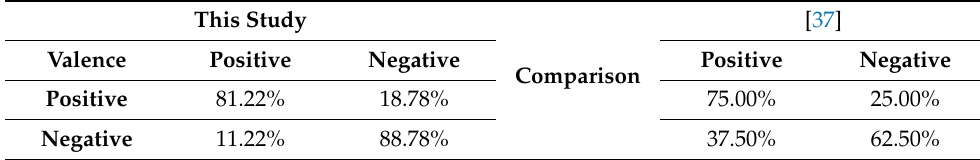
Table 12. Valence classification comparison of proposed approach versus existing